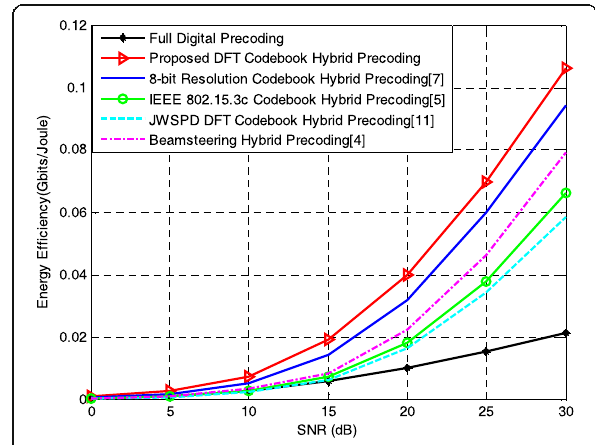
Fig. 6 The achievable sum rate vs. the number of RF chains